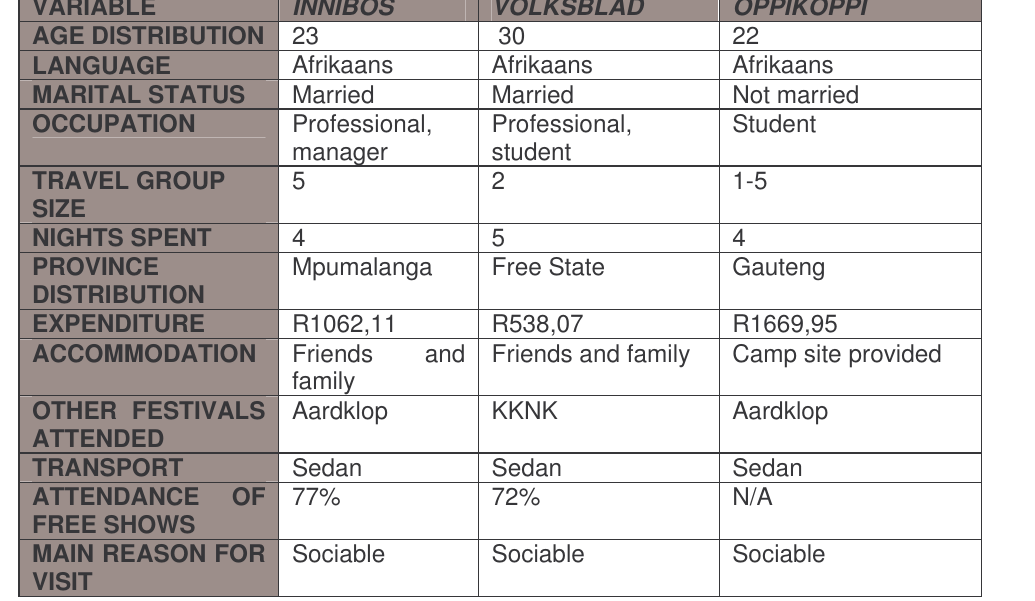
Table 2: Profile of festinos at the selected Festivals